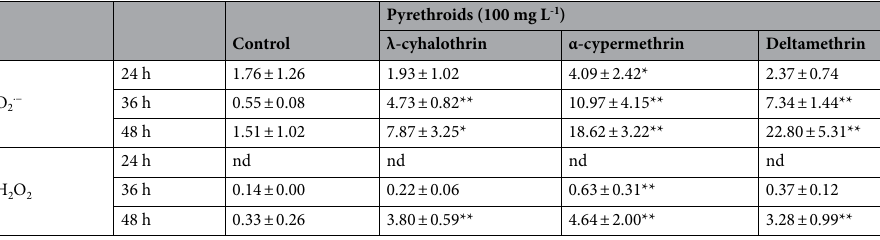
Table 5. Percentage of hyphae containing superoxide anion radicals and hydrogen peroxide in B. bassiana after incubation with λ-cyhalothrin, α-cypermethrin, and deltamethrin. Data are means ± SD; all samples were prepared in triplicate, and the experiments were repeated twice. Results were tested by one-way ANOVA; significance: ** P < 0.01, * P < 0.05. nd - not